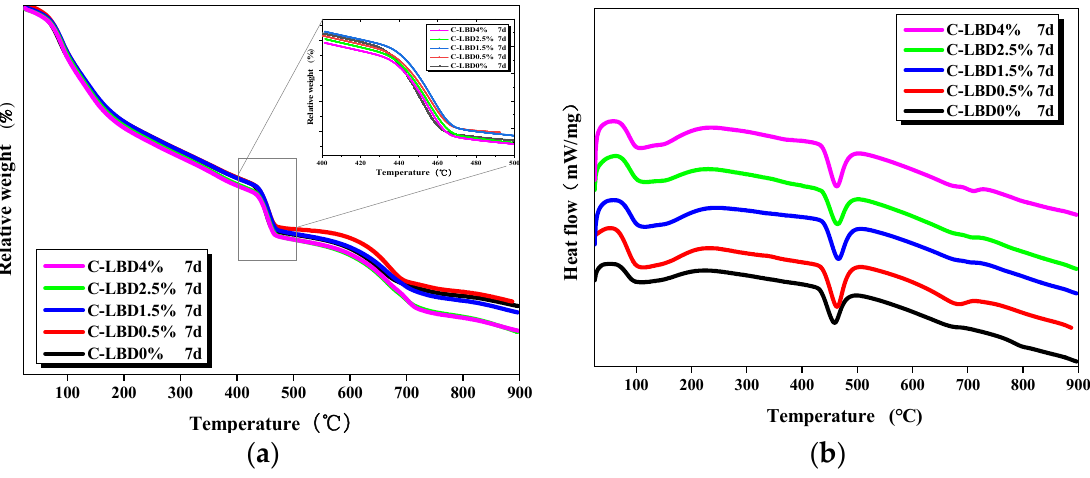
Figure 8. Thermal analysis curves of LBD/OPC pastes: ( a ) TG; ( b ) DSC.